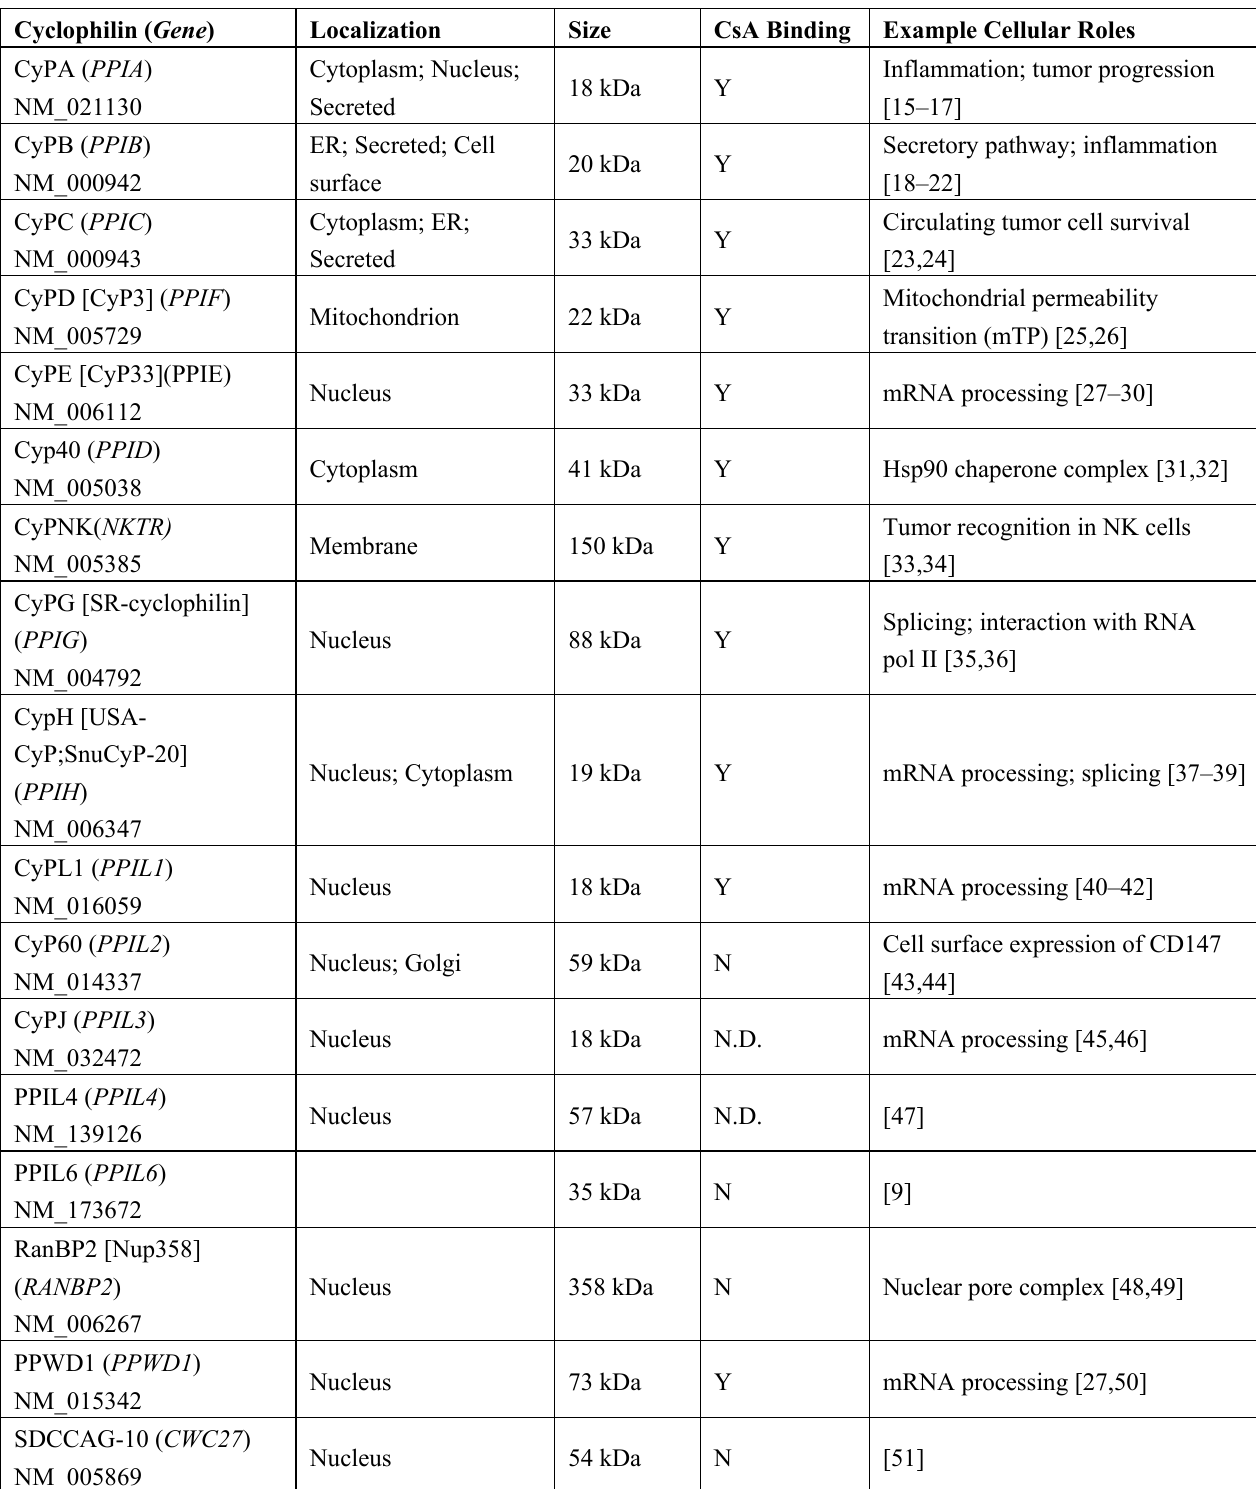
Table 1. Diversity of the